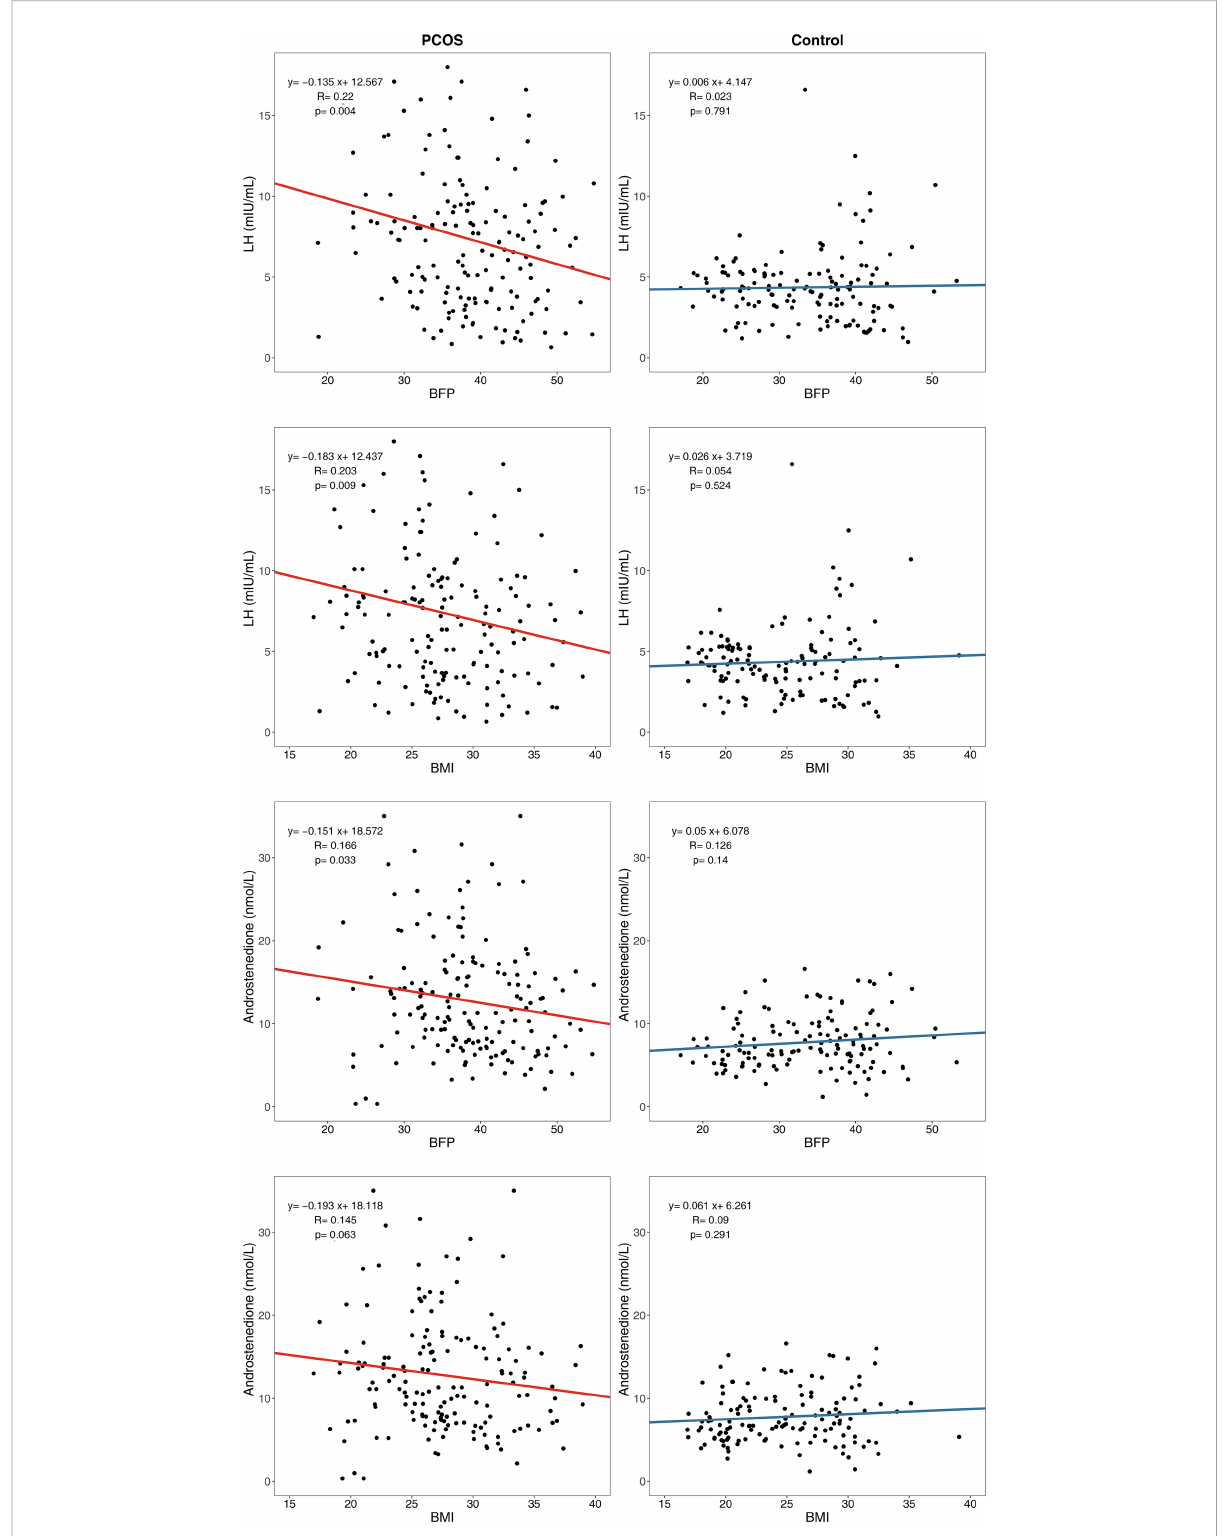
FIGURE 4 Linear regression between body composition index and endocrine index. LH, Luteinizing hormone; BFP, Body fat percentage; BMI, body mass